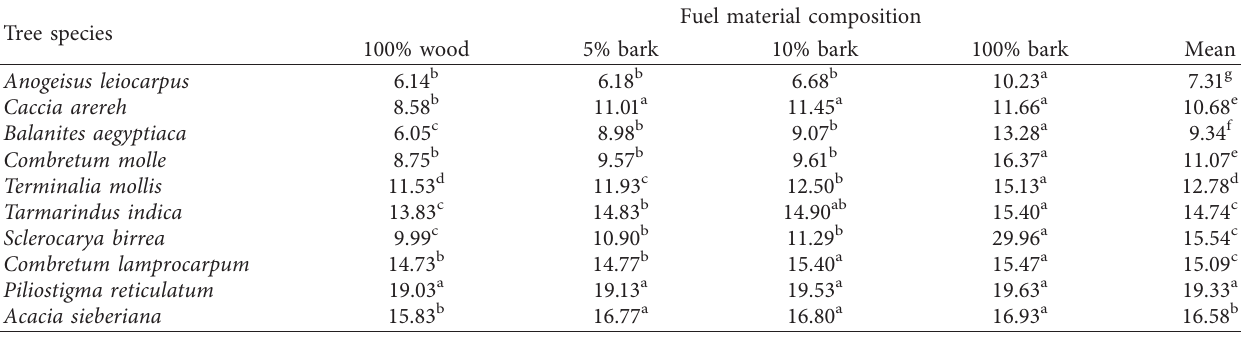
Table 6: Effect of bark inclusion on the extractive content (%) of selected fuelwood